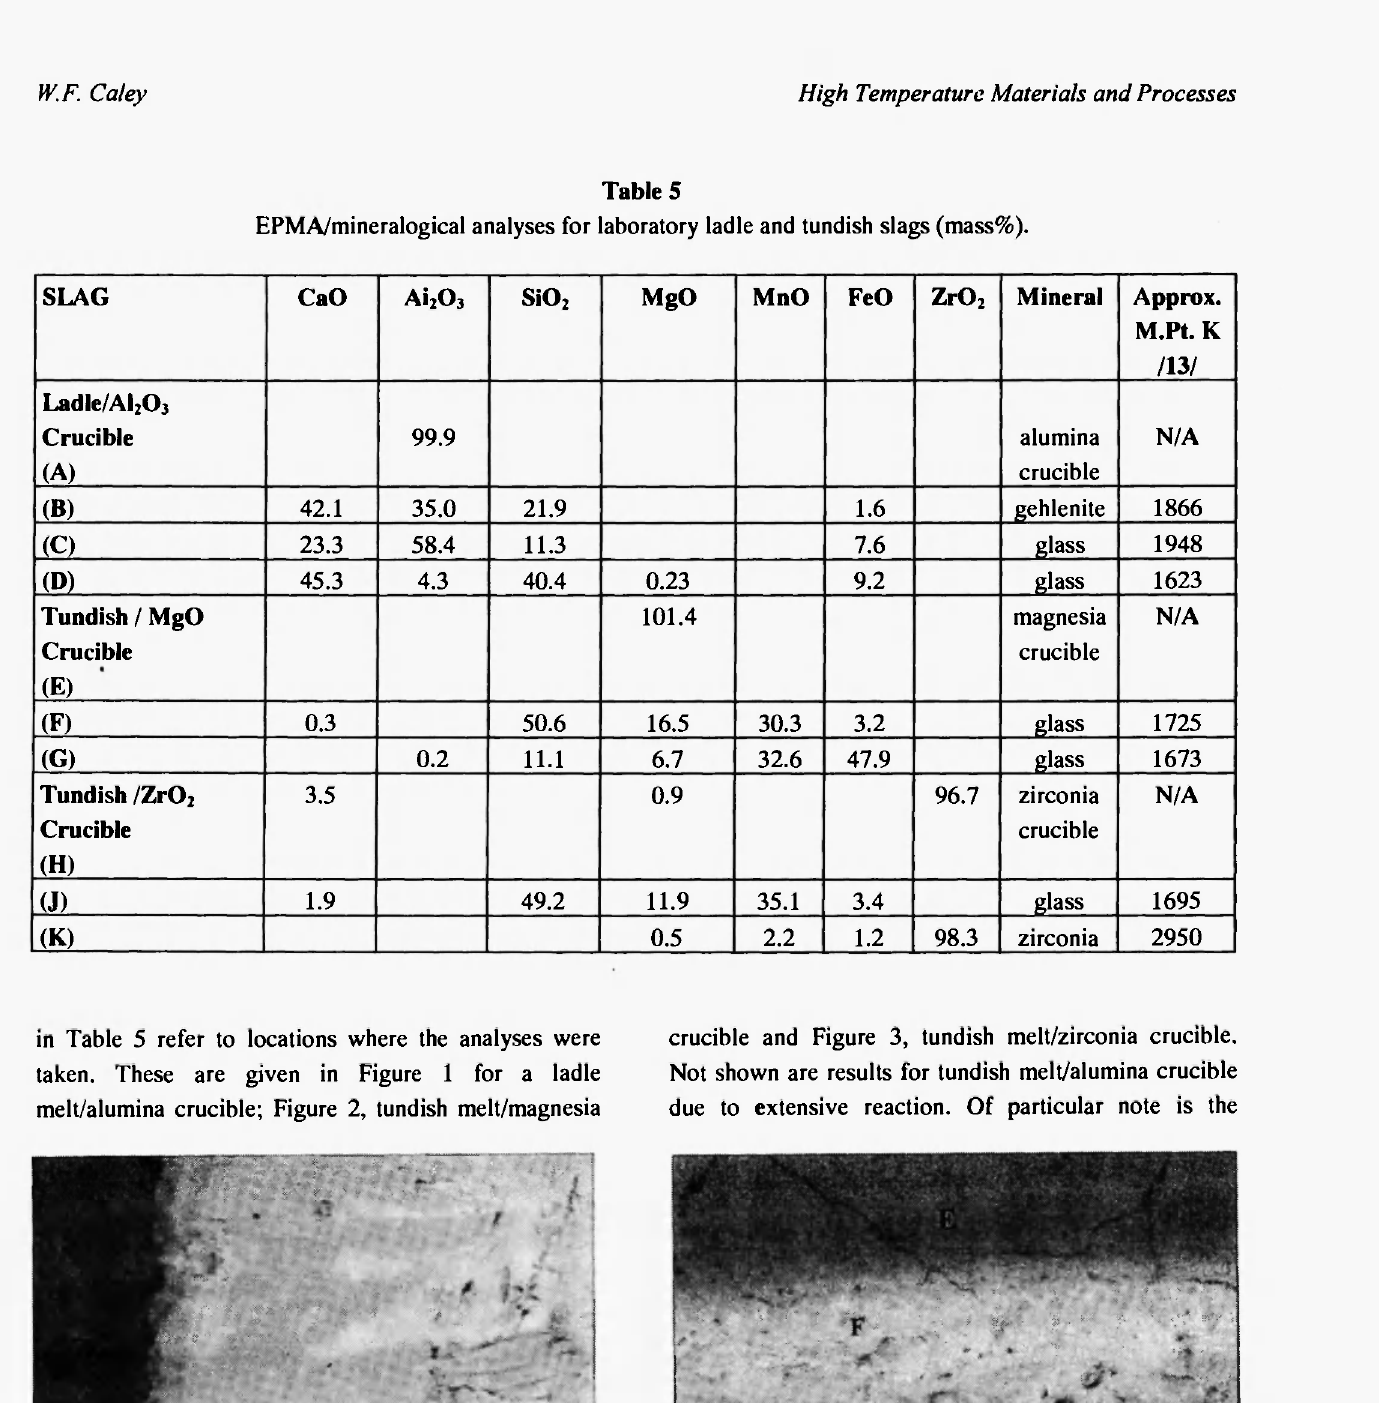
EPMA/mineralogical analyses for laboratory ladle and tundish slags (mass%).